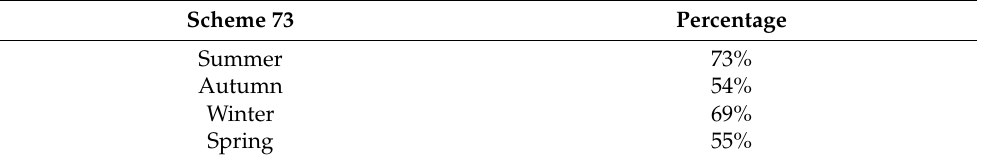
Table 2. Percentage of correct counting by software over manual counting.